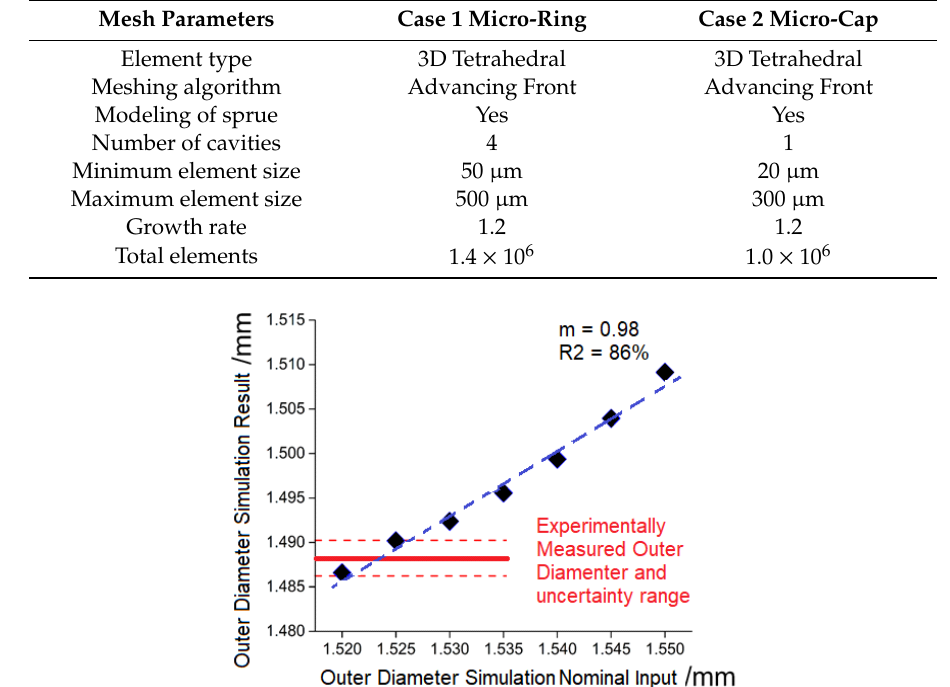
Figure 6. Design specification of the demonstrator with light selective reflection surface structures.